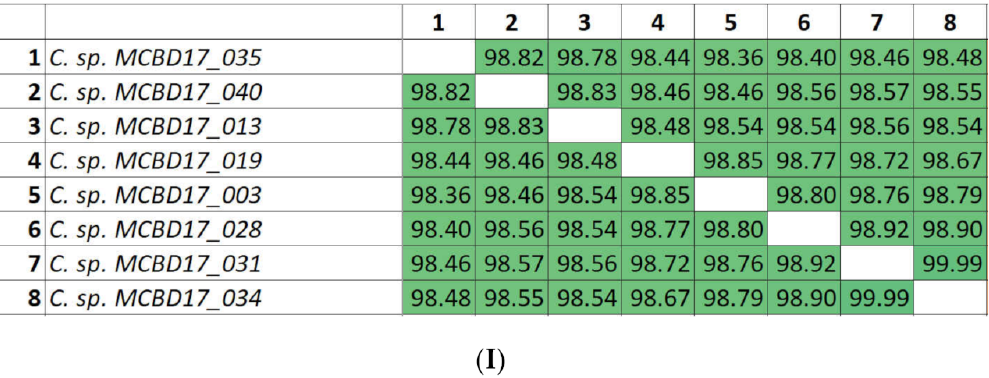
Figure 5. ANI matrix obtained by BioNJ clustering on 190 Curtobacterium genomes. ( A ) Group of strains proposed to be classified as Curtobacterium flaccumfaciens . ( B – I ) Clusters of strains containing proposed distinct genomospecies belonging to the genus of Curtobacterium . The strains which are coloured the same colour on the same image can be classified as representatives of the same genomospecies (Table 2). The abbreviations are as follows: C .— Curtobacterium , C. f. — Curtobacterium flaccumfaciens , and C. fpf — flaccumfaciens pv. flaccumfaciens